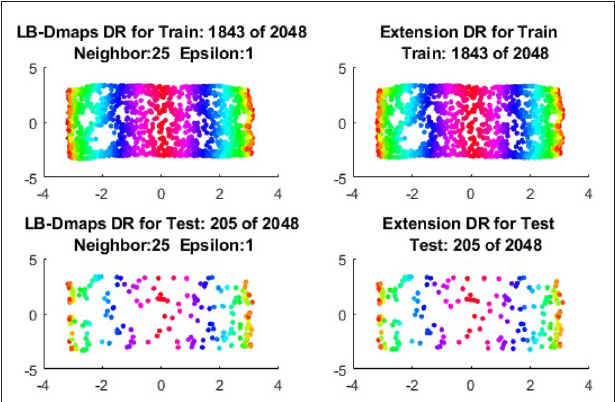
FIGURE 10 | Comparisons of DRs of training data and the testing data, respectively, for S-curve.